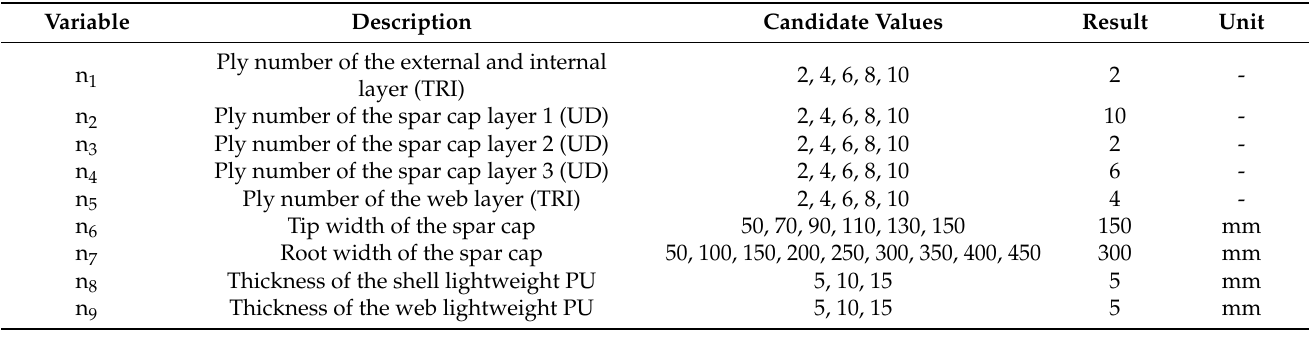
Table 8. Variables considered in the blade structural design.